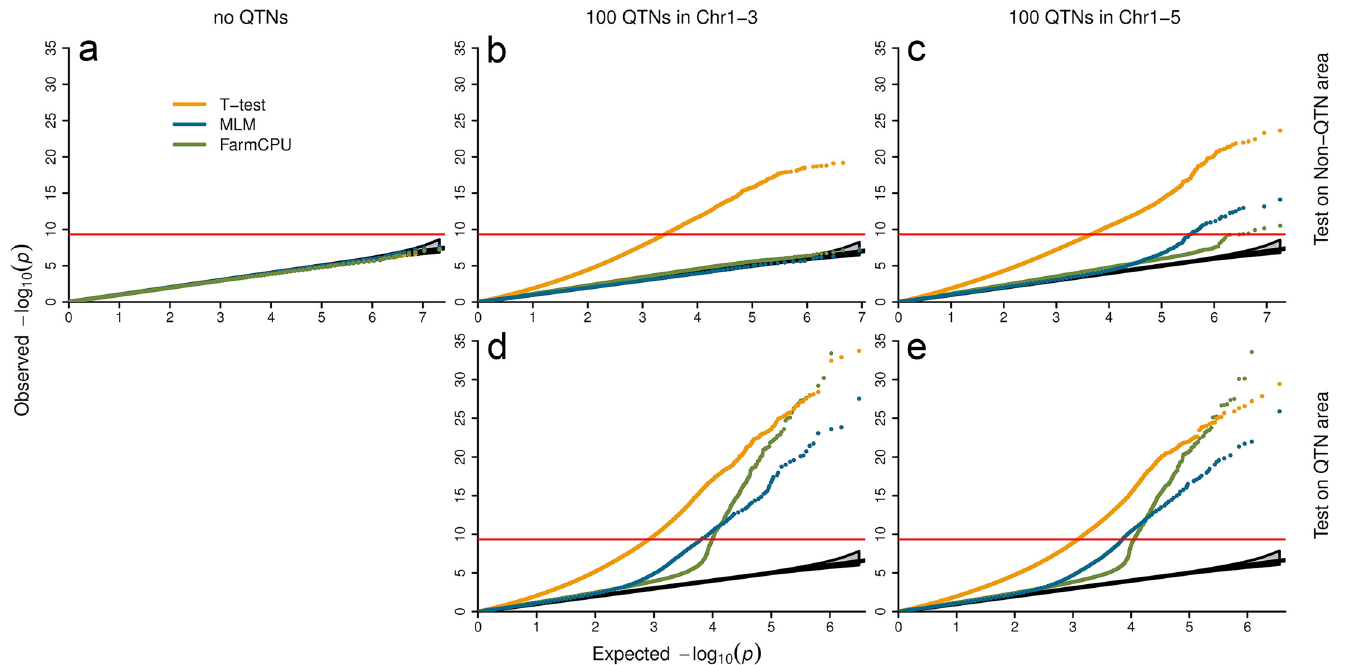
Fig 4. Null distribution of P values under different settings of confounding levels. The first setting contains no QTNs ( left panel ). The second setting restricts QTNs to first three chromosomes and left the rest two chromosomes as control ( middle panel ). The last setting spread QTNs on all five chromosomes ( right panel ). All the SNPs under first setting and all the SNPs on chromosome four and five under second settings were used to derive null distributions ( a and b ). The tests of SNPs on chromosomes one to three, including the ones used as QTNs are displayed in the middle panel at bottom ( d ). Under the third setting, SNPs are classified into the QTN areas and the non-QTN areas. A QTN area includes a QTN and its adjacent SNPs within 100,000 base pairs on each side. The rest are the non-QTN areas. The null distribution of non-QTN SNPs is displayed on the top right ( c ) and tests on the SNPs in QTN areas is displayed on the bottom right ( e ). Three statistical methods were examined: FarmCPU, Na ï ve (t-test) and MLM. The MLM included top six PCs, derived from 10% of SNPs sampled randomly, and used as covariates to control population structure. FarmCPU did not include PCs. The data is a structured Arabidopsis thaliana population that includes 1,178 individuals with 214,545 SNP markers. P values were from the association tests on a simulated trait controlled by 100 QTNs with heritability of 50% and QQ plots over 100 replicates are